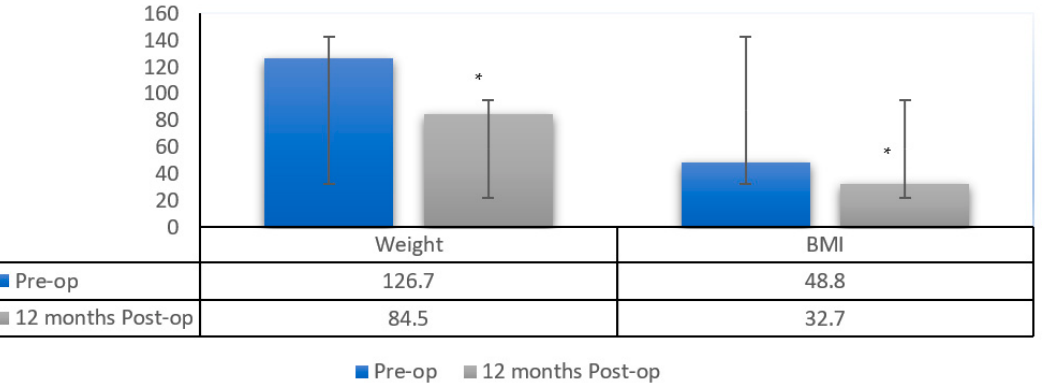
Figure 3. Comparison of weight and BMI pre-op and 12 months post-op . * Significant difference when compared with the preoperative value at p < 0.05.